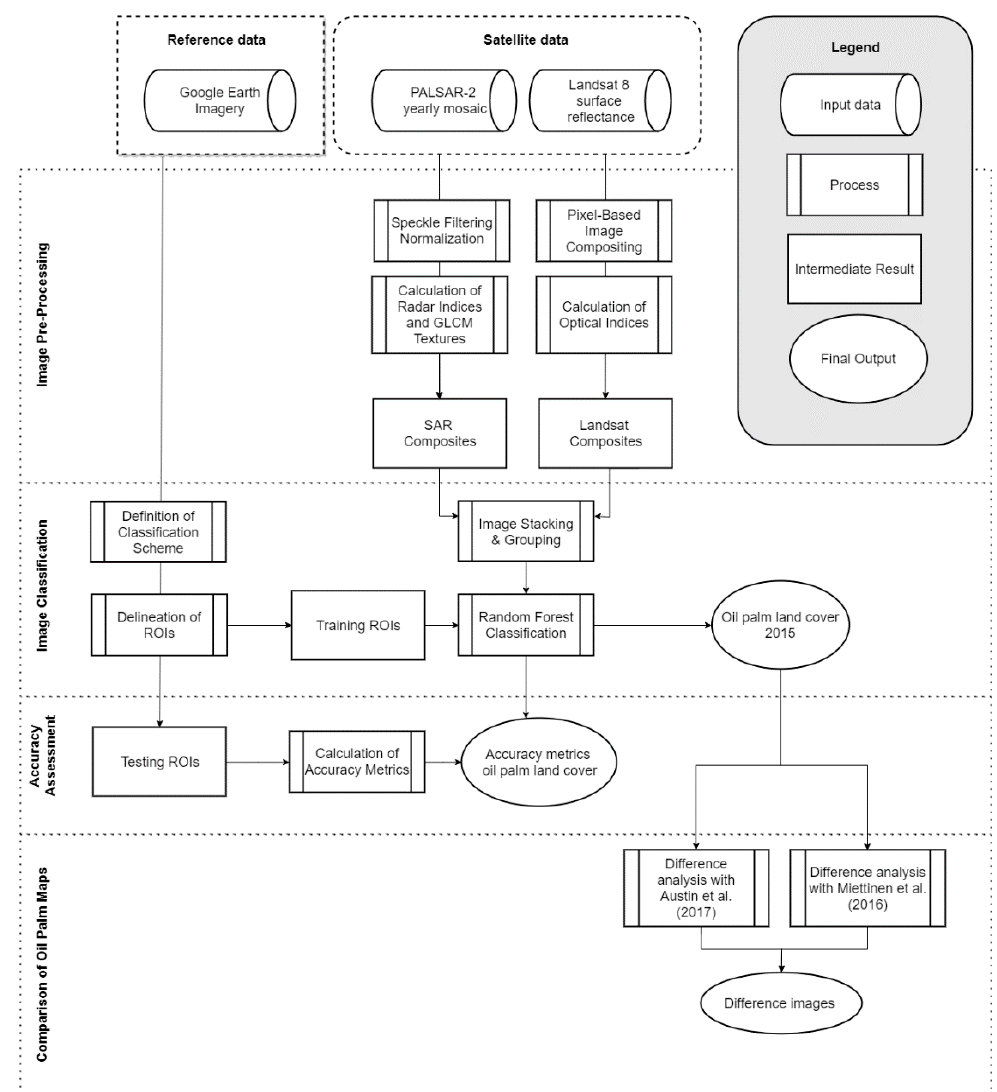
Figure 1. Overall workflow for mapping oil palm plantations in Riau, Jambi, and South Sumatra, which includes pre-processing of our phased array L-band synthetic aperture radar-2 (PALSAR-2) and Landsat 8 images, image classification using a random forest algorithm, developing accuracy assessments for our oil palm land cover map, and comparing our oil palm land cover map with two other oil palm map sources.